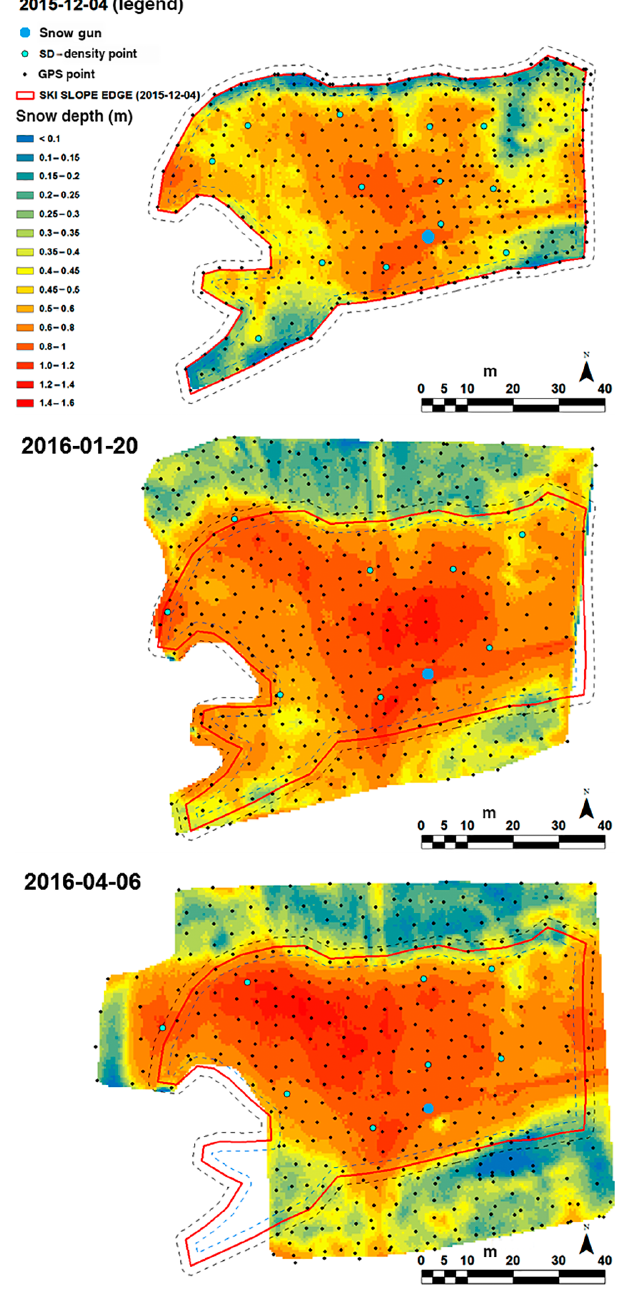
Figure 7. Snow depth mapping for the three observation dates 4 De- cember 2015 (top), 20 January 2016 (center) and 6 April 2016 (bot- tom). See Appendix A for details on the location of the observation